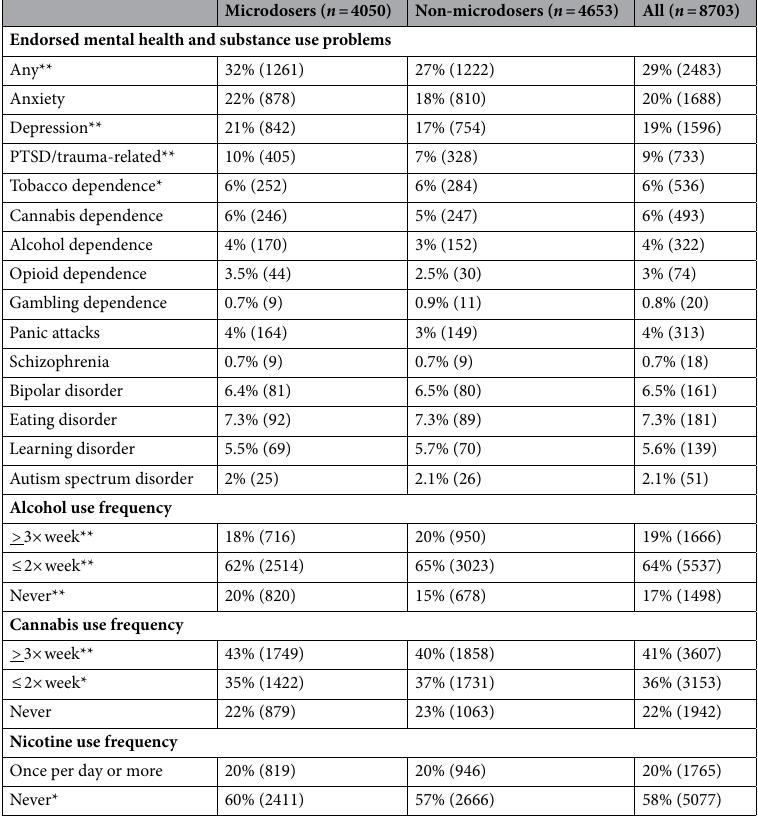
Table 2. Mental health and substance use. On variables with missing data, percentages reflect proportions of the total valid, non-missing, responses within a category. * p < 0.05, **p < 0.01.